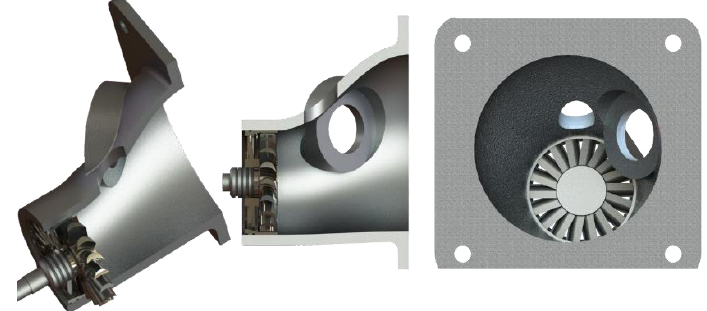
Figure 49. Proposed axial turbine with diffuser.